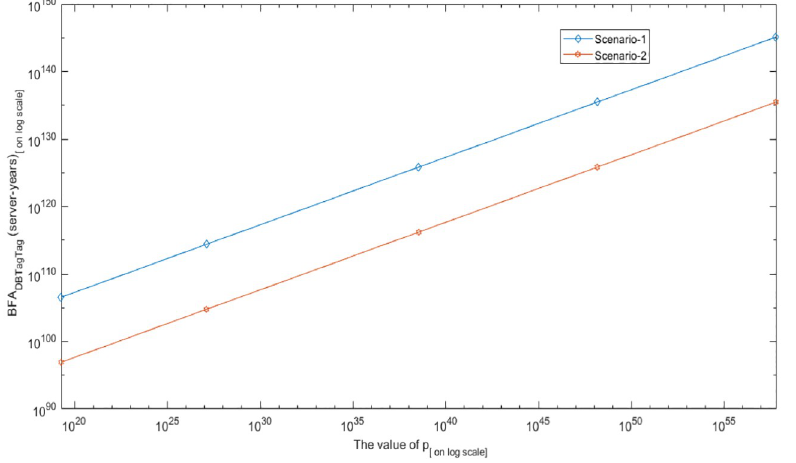
¼ 192 bits and L MappingSecretKey = 160 bits). E G 1